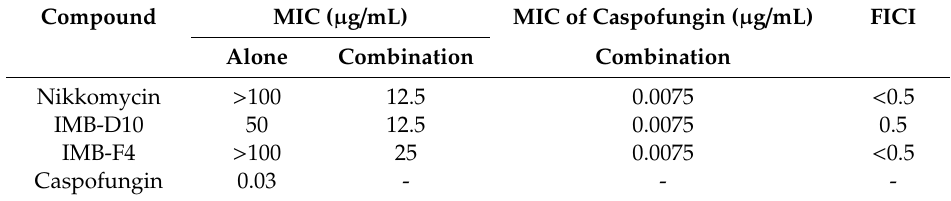
Table 1. The MICs ( µ g / mL) of compounds for WT, fks1 ∆ , and chs3 ∆ cells. Nikkomycin IMB-D10 IMB-F4 > 100 > 100 50